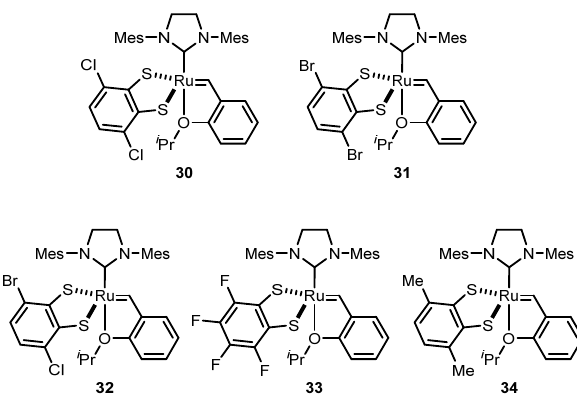
Figure 8. Design process for 29 . ( a ) Mimicking the design of the Mo and W Z -selective catalyst; ( b ) Observations showing the bottom-bound ruthenacycle is favored; ( c ) Employing a bidentate chelate that would induce a side-bound ruthenacyclobutane.